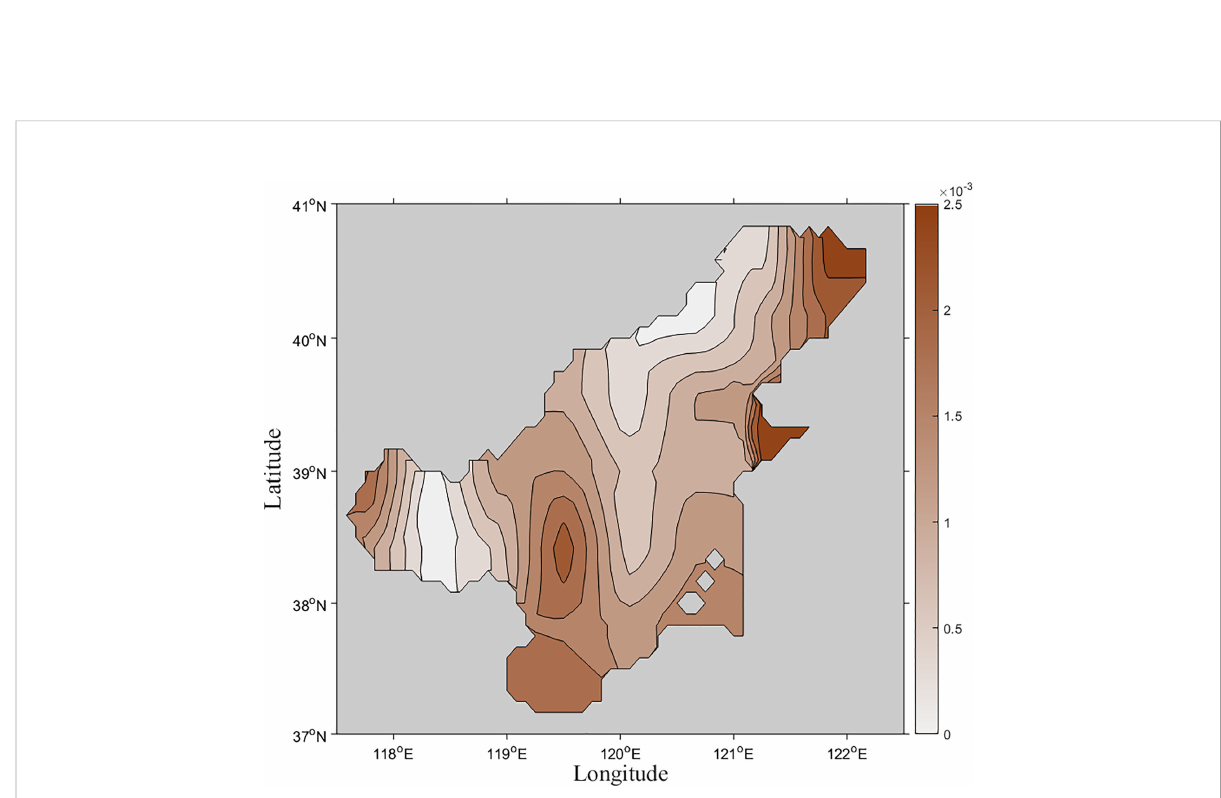
FIGURE 4 Estimated spatial distribution of BFCs for M 2 constituent in the Bohai Sea.